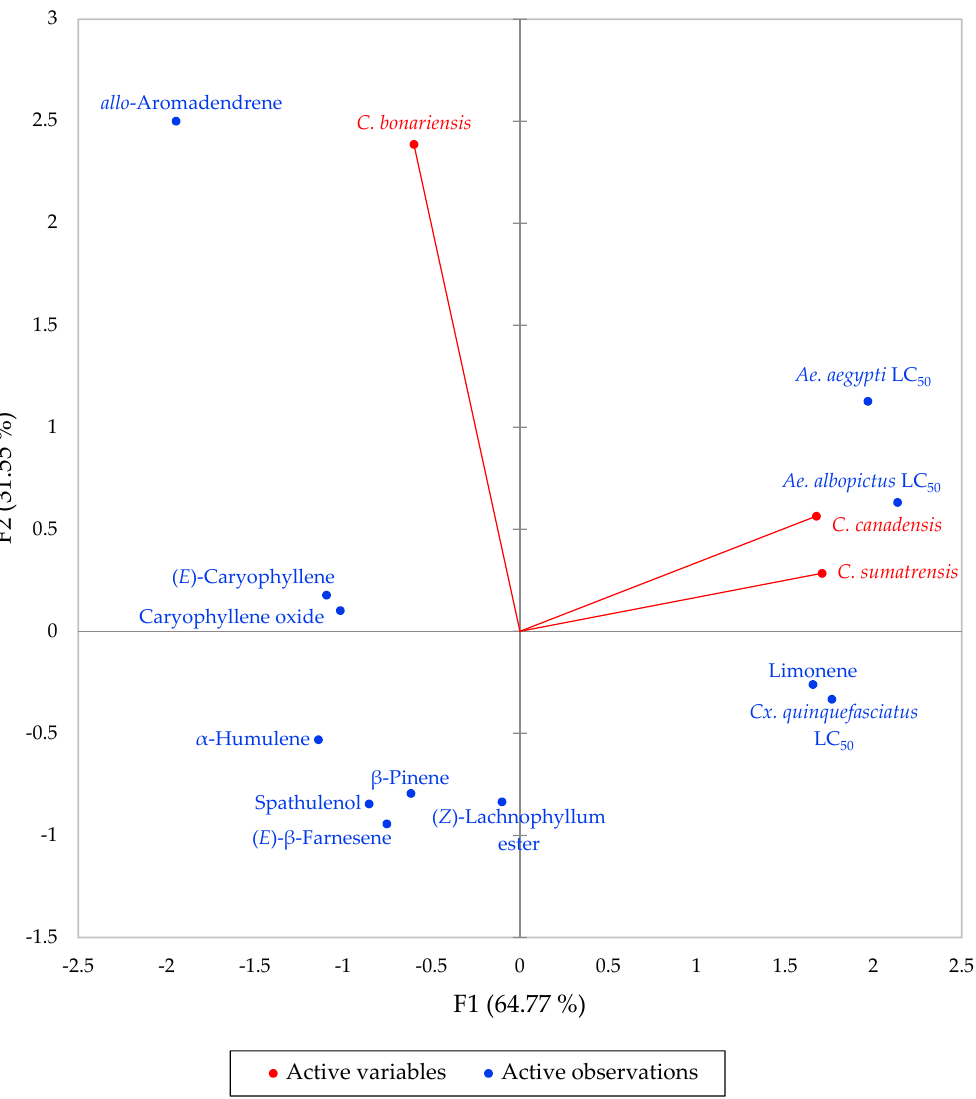
Figure 1. Principal component biplot of PC1 and PC2 scores and loadings demonstrating the relationships between Conyza essential oil major components and larvicidal activities.